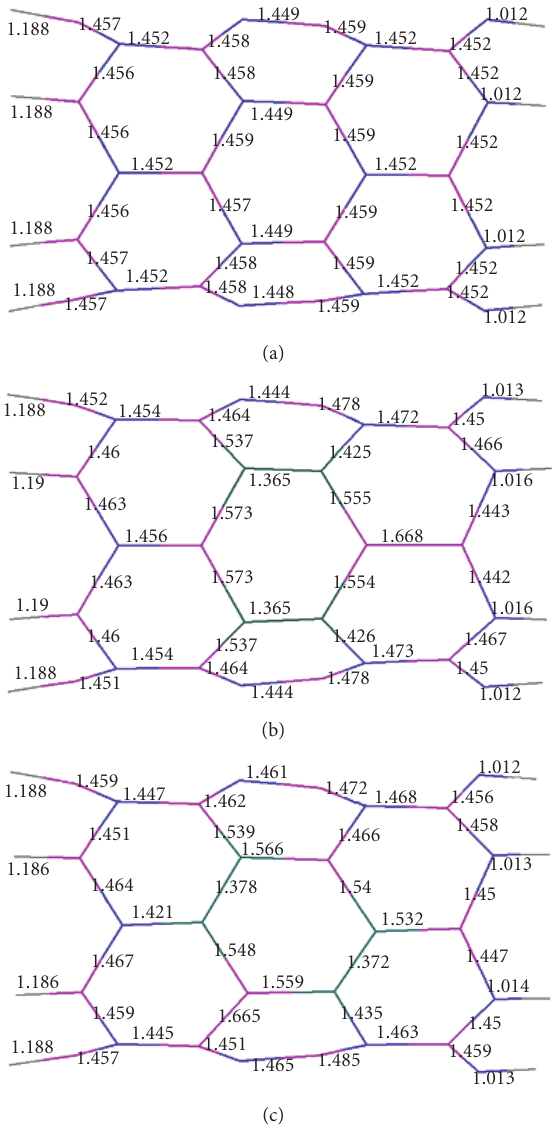
F 3: Optimized bond angles ( pure model, (b) and (c) diborinin-doped